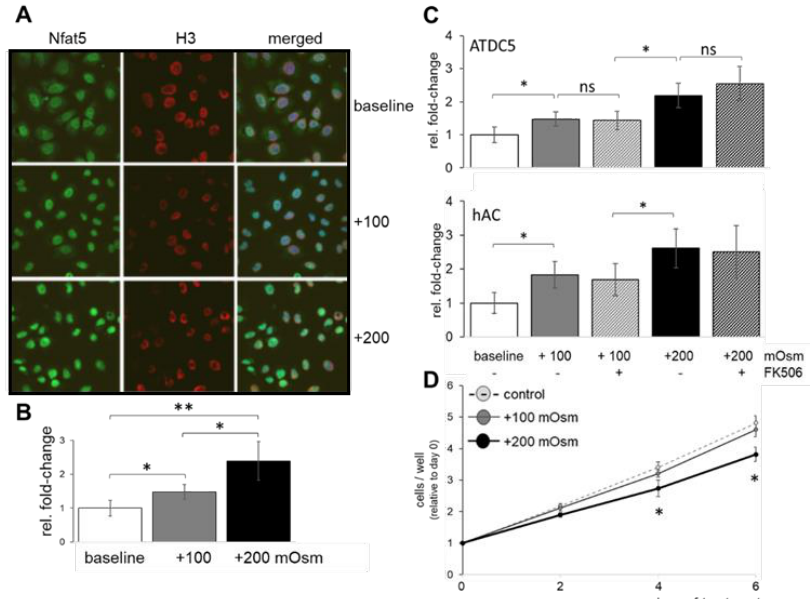
Figure 1. Effects of osmolarity and FK506 on sub-cellular localization of NFAT5 and cell proliferation. ( A ) Representative confocal microscopy images of the sub-cellular localization of NFAT5 (green) and ( B ) quantification of the changes in nuclear-to-cytoplasmic distribution of NFAT5 in ATDC5 cells within 2 h. ( C ) Increasing culture medium osmolarity over plasma level (baseline) by +100 and +200 mOsm/kg, respectively, significantly changed sub-cellular distribution of NFAT5 in ATDC5 cells and human articular chondrocytes (hAC), while adding FK506 (620 nM) did not. ( D ) Increasing the osmotic value of the culture medium beyond +100 mOsm/kg negatively influenced ATDC5 cell proliferation. Ubiquitously expressed histone H3 (H3), red; ns, not significant; * , p < 0.05; **, p < 0.01.